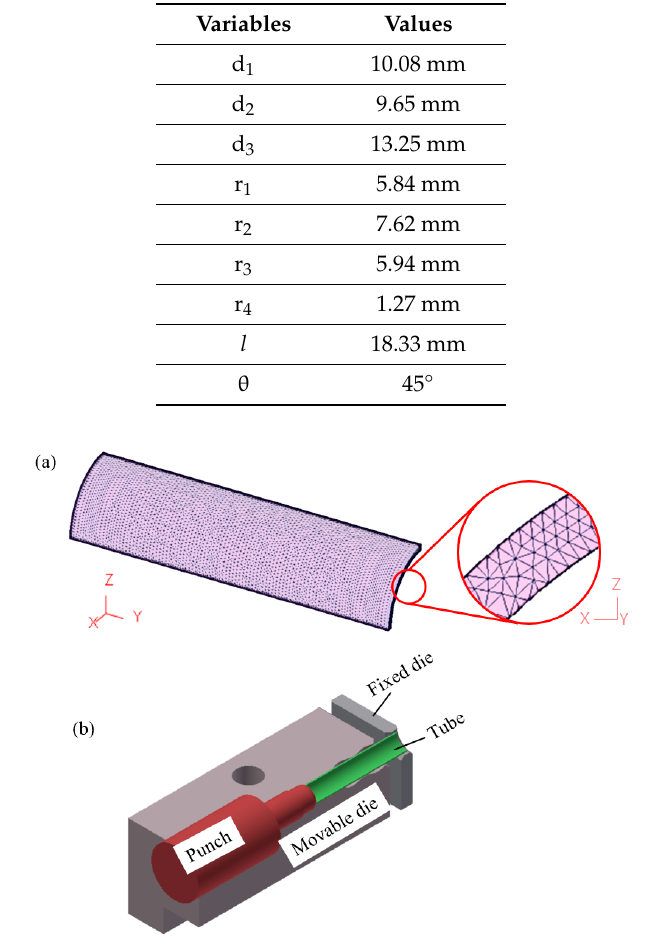
Table 2. Dimensions of simulated irregular bellows.